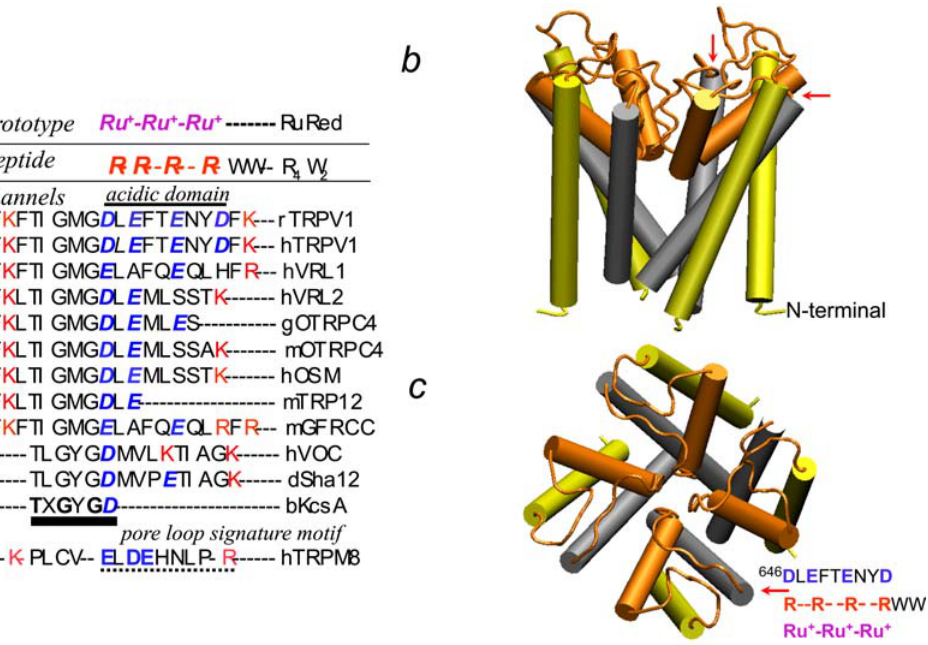
Figure 10. (a) Homologous portions of various TRP channels, near the border of the pore loop and the 6 th transmembrane domain were aligned with a validated R 4 W 2 peptide similar in biochemical character to ruthenium red. An acidic tetrad motif D X E XX E XX D which can bind the positively charged peptides in human and rat TRPV1, is absent in TRPV2/VRL1 and TRPV3, (both close homologues of TRPV1) as well as in distantly related TRPs and bKcsA, a bacterial cation channel. An acidic sequence, partially similar to the heat sensitive TRPs, is present in the cold responsive TRPM8/CMR1. Distant TRPV homologues do not share the acidic tetrad motif either, such as g/mOTRPC4 and hOSM, nonselective cation channel orthologues from Gallus gallus (chicken), mouse, and human, respectively that confer sensitivity to extracellular osmolarity, mTRP12, another osmotically activated